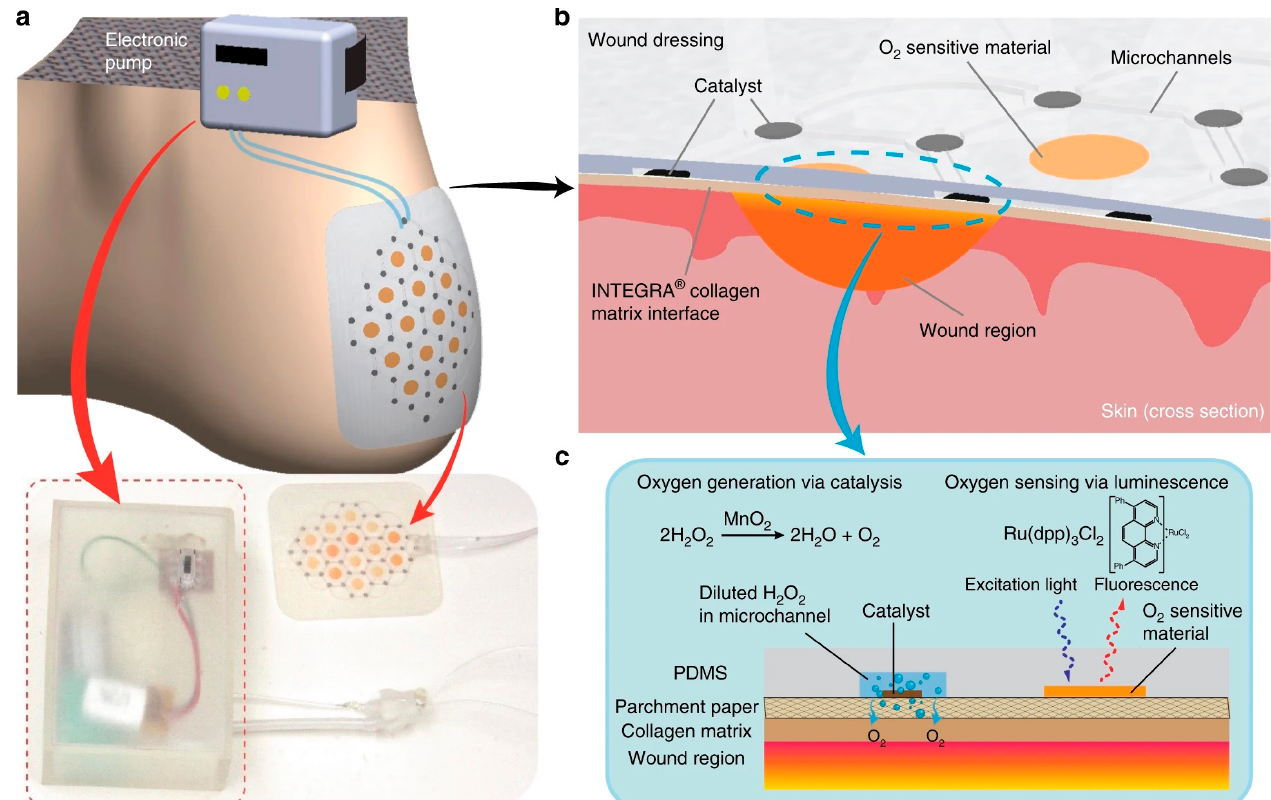
Figure 4. Smart stimuli responsive wound dressings. ( a ) Schematic illustration of smart stimuli responsive wound patch for foot ulcers treatment, ( b ) oxygen generation and sensing through smart wound patch in wound area, and ( c ) mechanism of oxygen generation for sensing using flexible smart wound dressings. Reproduced from ref. [72] with permission from Nature Publishing Group.